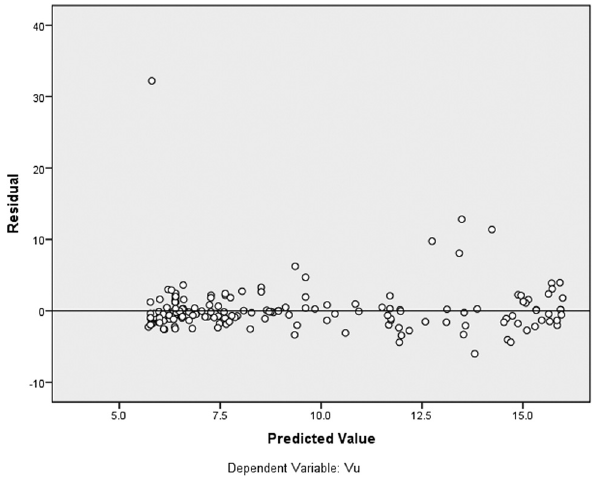
Figure 5: Residuals of simulated data of recent ANN model ( from SPSSV.19 software ) .